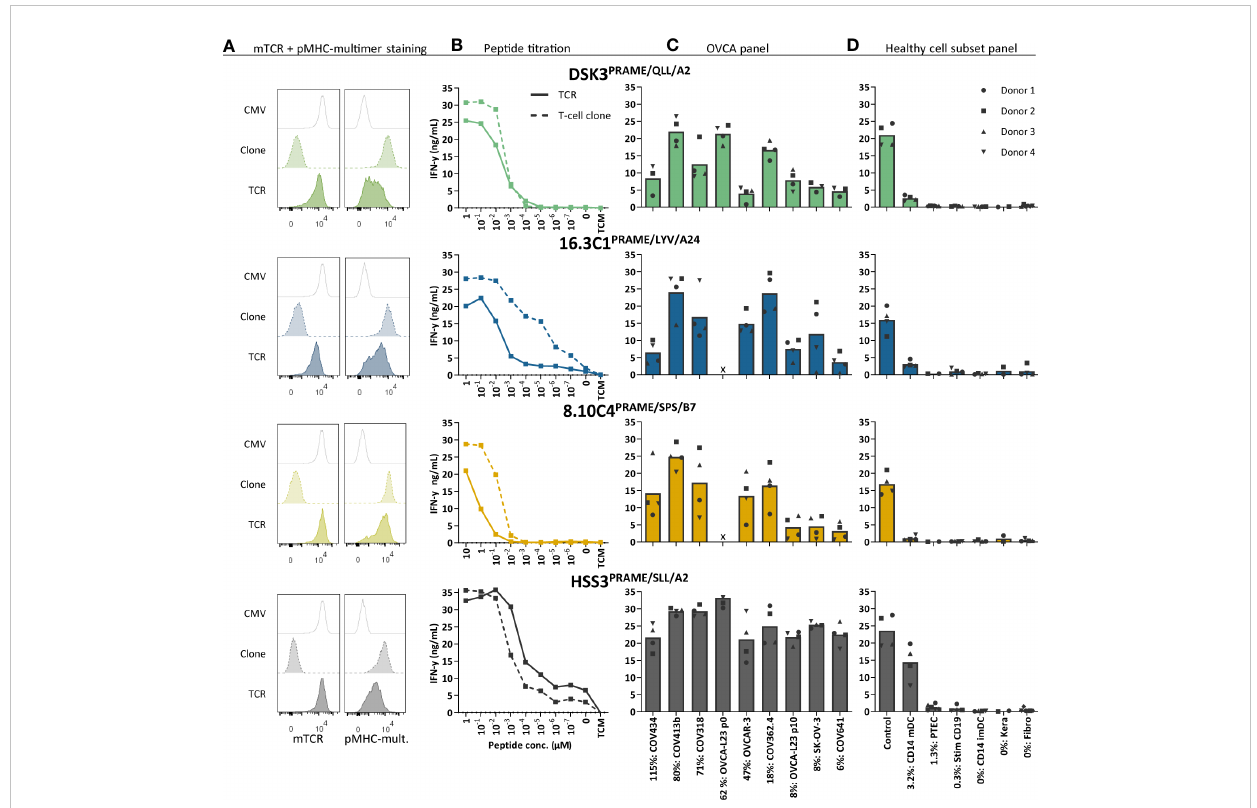
FIGURE 4 Three new PRAME TCR-T cells recognize PRAME positive OVCA cells and mature DCs. The three new PRAME TCRs and clinically tested HSS3 TCR were introduced via retroviral transduction in CD8+ cells of four different donors. (A) Representative fl ow cytometry plots of puri fi ed CMV and PRAME TCR-T cells, and their parental PRAME T-cell clones stained with murine TCR (mTCR) and the PRAME-speci fi c pMHC-mult. (B) IFN- g production (ng/mL) of TCR-T cells and their parental T-cell clones cocultured overnight with Raji cells (transduced with HLA-A2, A24 or B7) loaded with titrated peptide concentrations (E:T = 1:6). (C) IFN- g production of TCR-T cells cocultured with OVCA cells (E:T = 1:6). All OVCA cells express the HLA allele that presents the targeted peptide, either wildtype or the HLA allele was introduced by transduction. Primary malignant ascites patient sample OVCA-L23 (wildtype HLA-A2) was either passage 0 (included for TCR DSK3 and HSS3) or passage 10 transduced with HLA-A24 or B7 (included for all TCRs). (D) IFN- g production of TCR-T cells cocultured with several healthy cell subsets (E:T = 1:4 for keratinocytes, fi broblasts, PTECs and CD14+, 1:6 for CD19+). Cell subsets were isolated from multiple HLA-A2+, A24+ and/or B7+ donors. (C-D) Percentage relative PRAME expression is depicted, as determined by qPCR. Bars represent mean and symbols depict averaged duplicate values from four different donors